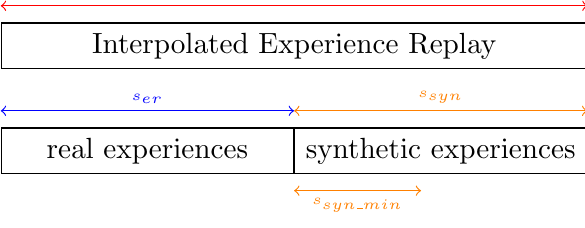
Figure 3. Intuition of Interpolated Experience Replay